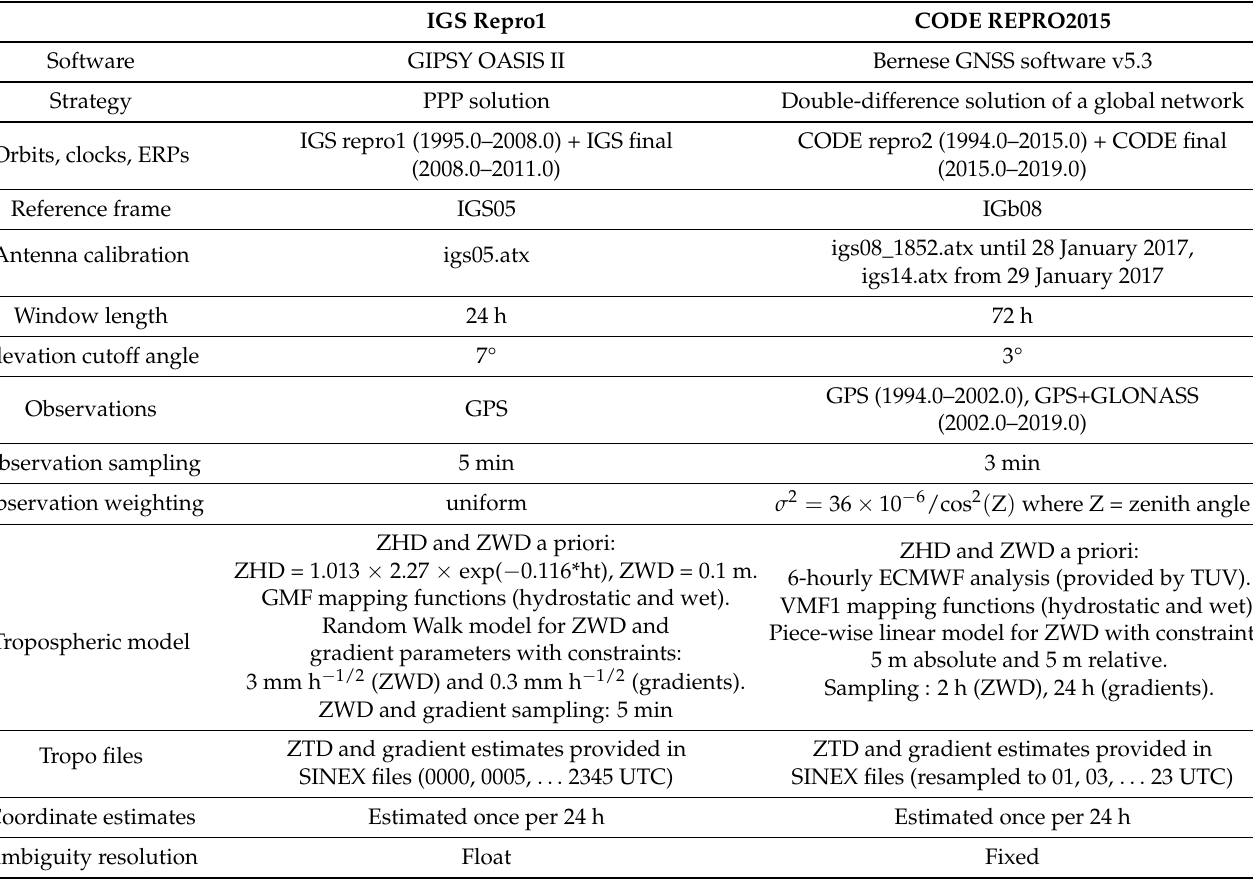
Table 1. Processing strategies used by JPL/NASA to produce the IGS first reprocessed tropospheric data set (IGS repro1) and by the Center for Orbit Determination in Europe (CODE) to produce the CODE REPRO2015 reprocessed data set. IGS Repro1 CODE REPRO2015 Software GIPSY OASIS II Bernese GNSS software v5.3 PPP solution Double-difference solution of a global